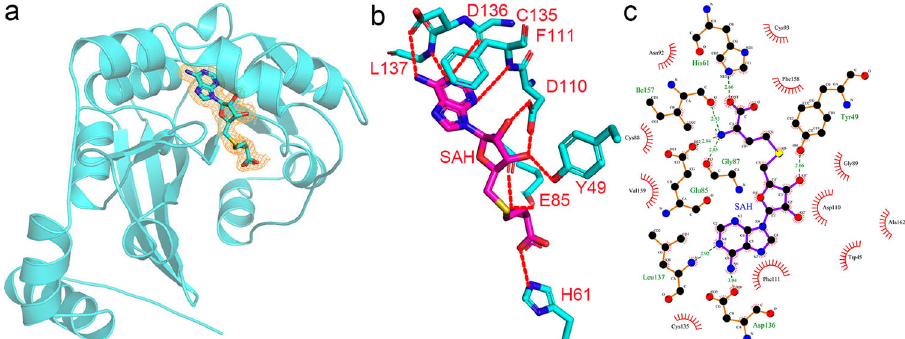
Fig. 2 The interaction network of SAH bound by hMETTL6. a The composite omit map was countered at 2 σ and indicated by the orange mesh. b The interaction network that SAH participates in hMETTL6. The dashed lines indicated hydrogen bonds. c The ligplot showing the interactions of SAH with the active site residues.